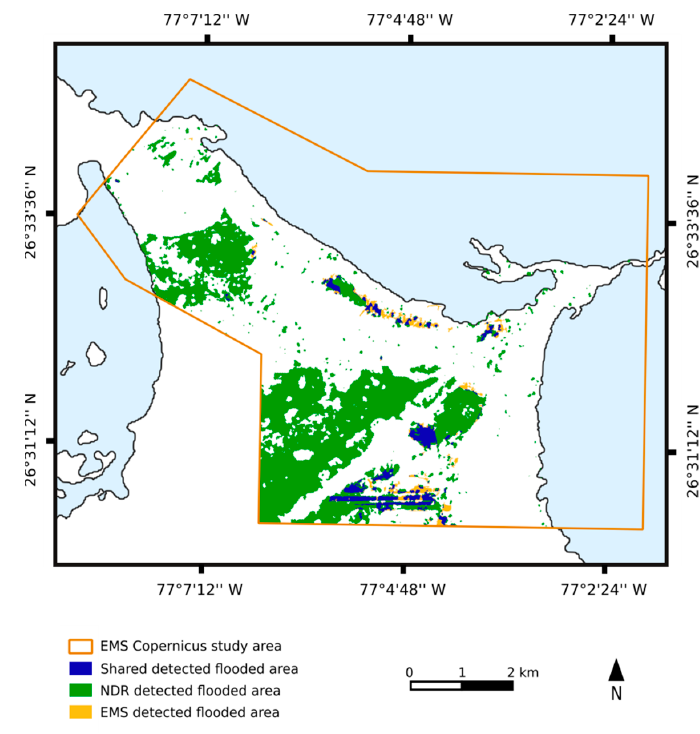
Figure 7. Flood detection comparison between NDR and EMS Copernicus in Marsh Harbour area.